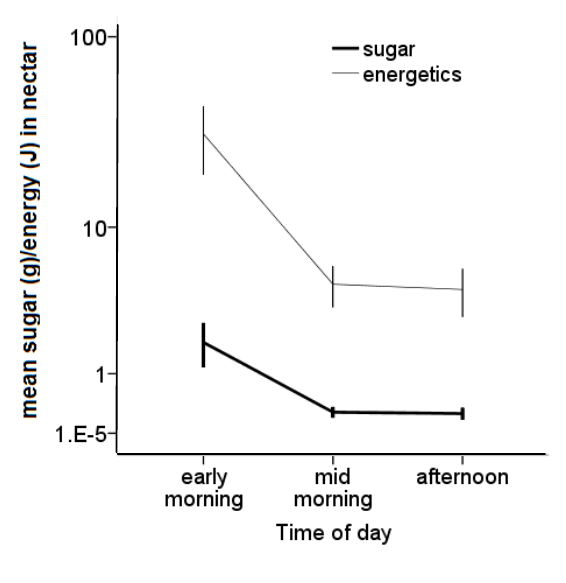
F IG . 2. Daily variation of sugar content (mg) in nectar